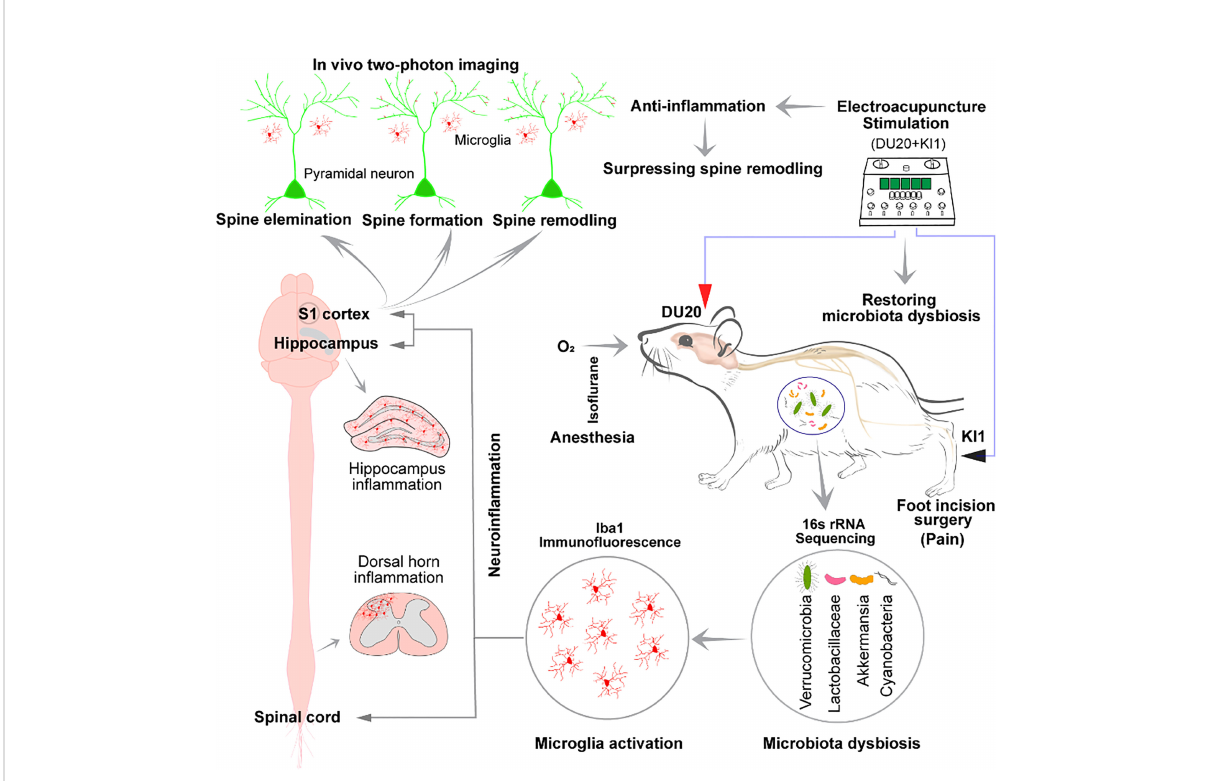
FIGURE 6 Hypothesized pathway of surgical pain-induced delirium-like behavior. Surgical incision in the foot causes pain and delirium-like behavior in mice; changes in gut microbiota; microglia activation at spinal dorsal horn, hippocampus, and somatosensory cortex in mice; and remodeling of the cortical dendritic spine in mice. EA stimulation at speci fi c acupoints DU20+KI1 ameliorated these changes. Mechanistically, we hypothesize that surgical pain increased microglia activation and dendritic spine remodeling, which are mediated by gut microbiota dysbiosis, leading to delirium-like behavior in